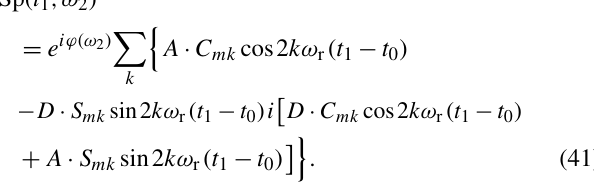
This quantity should be constant within 0.1 % across the dif- ferent t 1 increments. No change in intensity could be detected within the limits of experimental uncertainty.